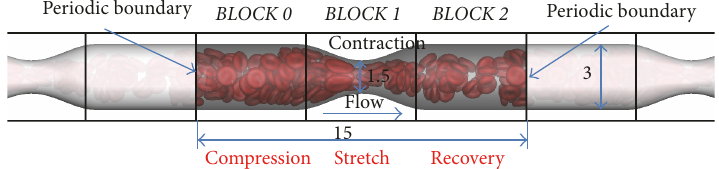
Figure 6: Schematic of the simulation on RBC transport through a confined tube (all sizes are normalized with the RBC diameter: 𝐷 ).